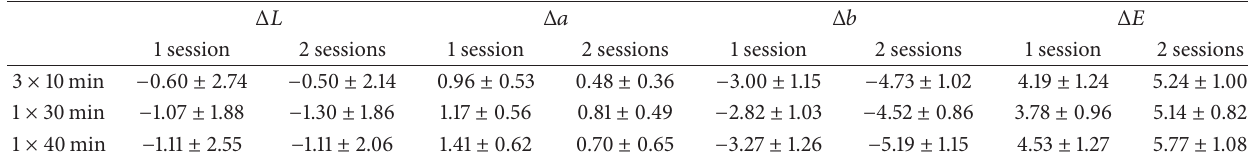
Table 1: Mean and standard deviations of color parameters for all experimental